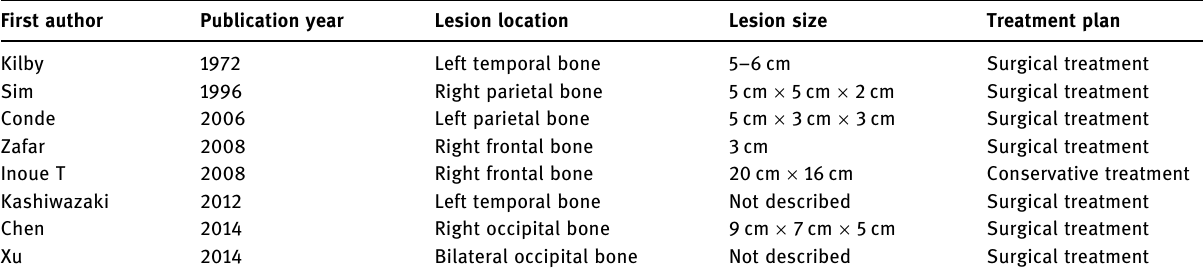
Table 1: Summary of cases of skull hemophilia pseudotumor First